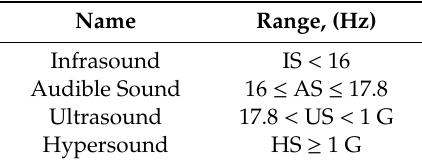
Table 1. Acoustic frequency